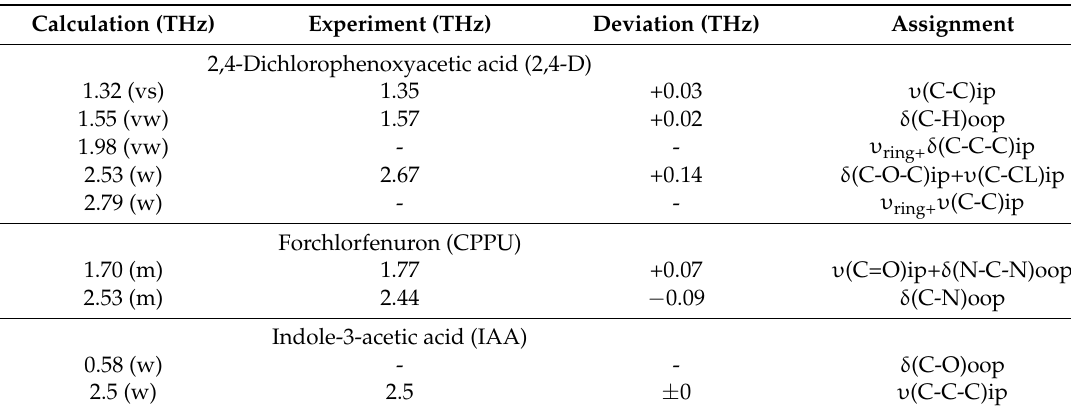
Table 2. The assignment of the calculated absorption